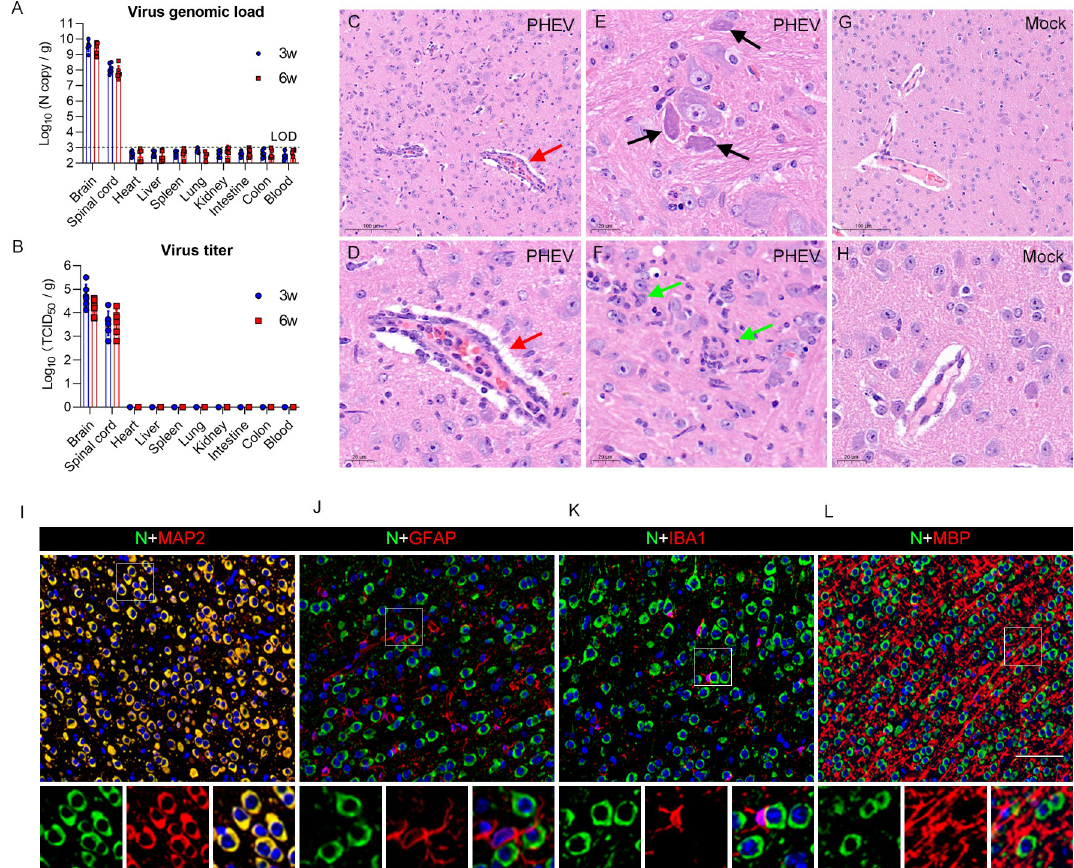
Fig 3. Brain damage and viral tropism in the CNS of PHEV-infected mice. (A-B) The 3w and 6w BALB/c mice were inoculated with 10 3.96 TCID 50 PHEV and samples were collected at 5 dpi for qRT–PCR and viral titer determination (n = 6). (A) Viral genome loads were monitored in different organs and blood. The limit of detection (LOD) is shown with a dashed line. (B) Infectious viral titers were detected in different organs (n = 6). ( C-L ) The 3w BALB/c mice were intranasally inoculated with 10 3.96 TCID 50 PHEV. Mice were euthanized at 5 dpi, and brain samples were harvested for histopathological examination. (C-H) H&E staining of brain sections from control and PHEV-infected mice. (C-D) Lymphocytic perivascular cuffing (red arrows). (E) Dying neurons undergoing degeneration (black arrows). (F) Microglial nodules (green arrows). (G-H) Brains from mock-infected mice. (I-L) Immunofluorescence images of PHEV-infected neurons in 3w BALB/c mice. MAP-2, GFAP, IBA1, and MBP are markers for neurons, astrocytes, microglia, and oligodendroglia, respectively. Scale bars, 100 μ m (C , G ), 20 μ m ( D-F , H ), and 50 μ m ( I-L